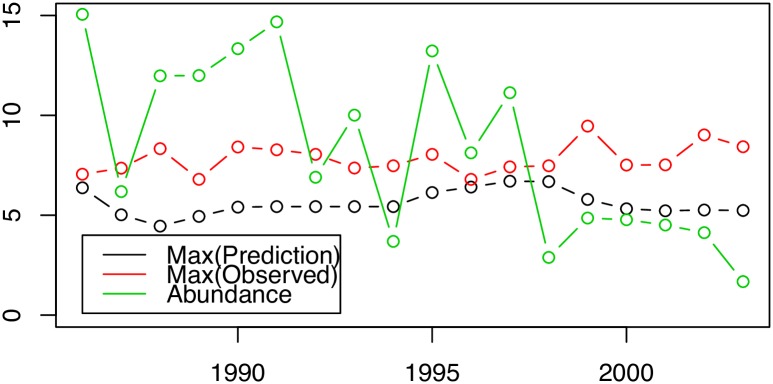
Hyperstability.The maximum observed count (LogY), the maximum predicted count (eta) are nearly constant, even though the stock is collapsing.